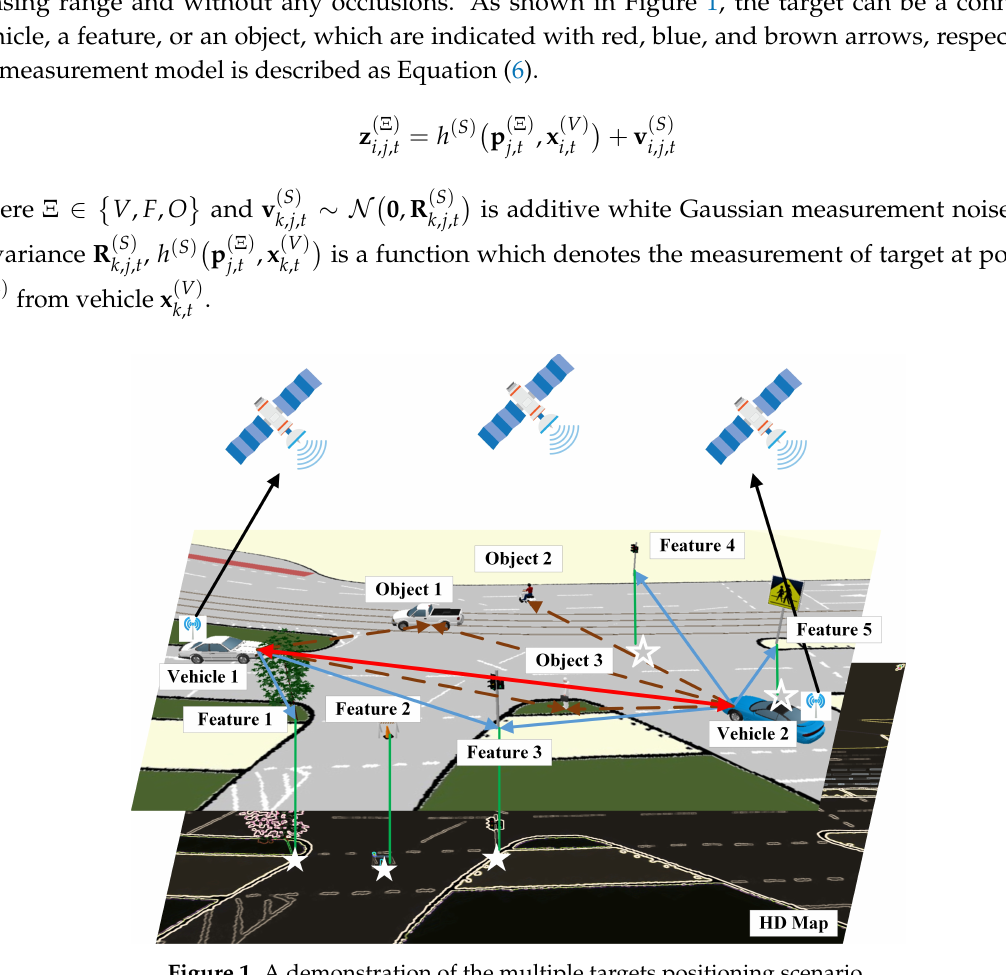
Figure 1. A demonstration of the multiple targets positioning